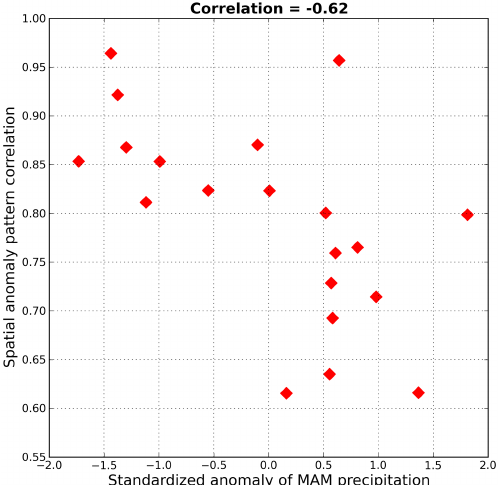
Figure 11. Comparison between spatial anomaly pattern correlation (between MAM mean soil moisture forecast initialized at the start of season and observation) and standardized anomaly of MAM precip- itation. This plot indicates that spatial anomaly pattern correlation is generally higher ( > 0.8) during drought years (when standardized anomaly of MAM precipitation is <